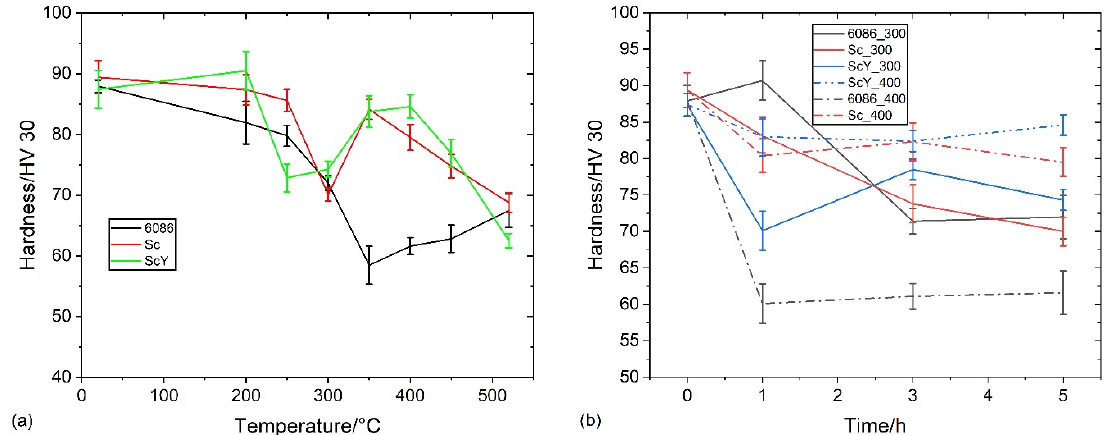
Figure 23. Heat treatment of the investigated alloys in the as-cast condition. ( a ) The e ff ect of the fi ve- hour isochronal ageing on the hardness at di ff erent temperatures. ( b ) The e ff ect of the isothermal treatments duration on hardness at 300 °C and 400 °C.